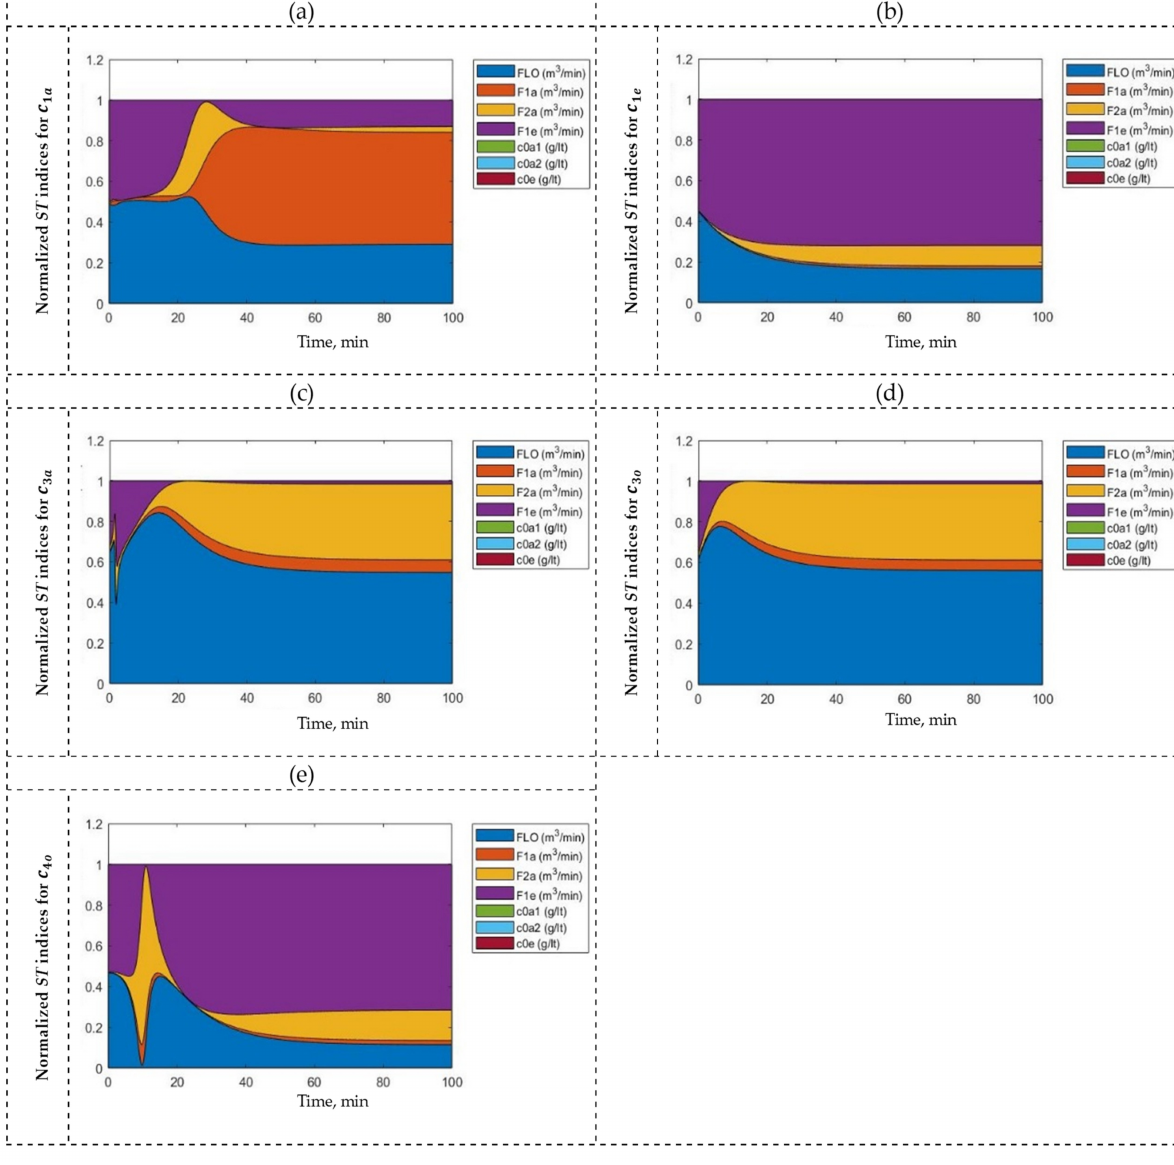
Figure 10. GSA using ( a ) c 1 a , ( b ) c 1 e , ( c ) c 3 a , ( d ) c 3 o , and ( e ) c 4 o as output variables. Step 3.